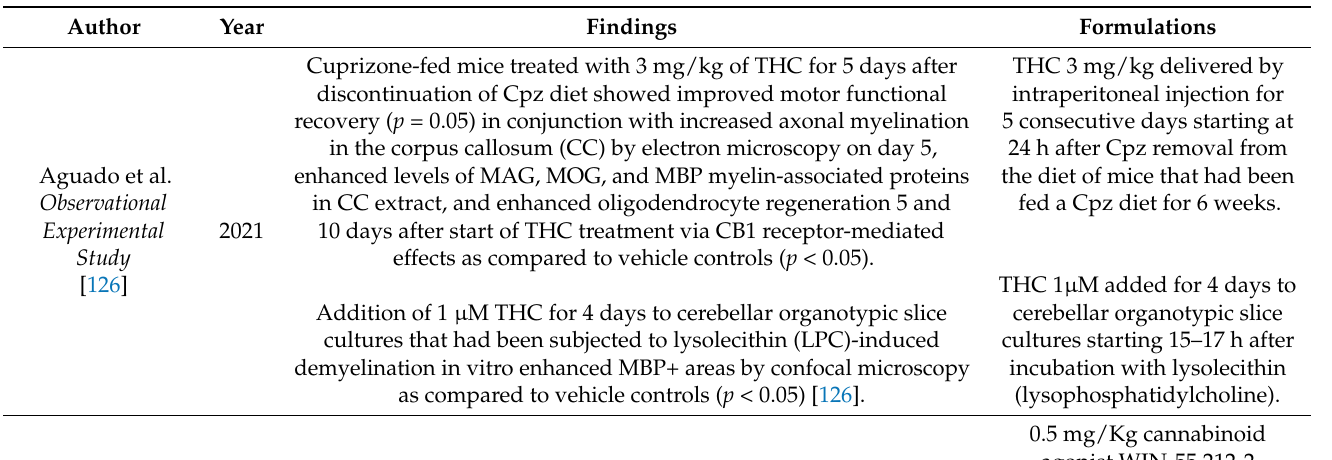
Table 6. Effects of cannabinoids on inflammation and spasticity in TMEV-IDD and toxin-induced demyelination